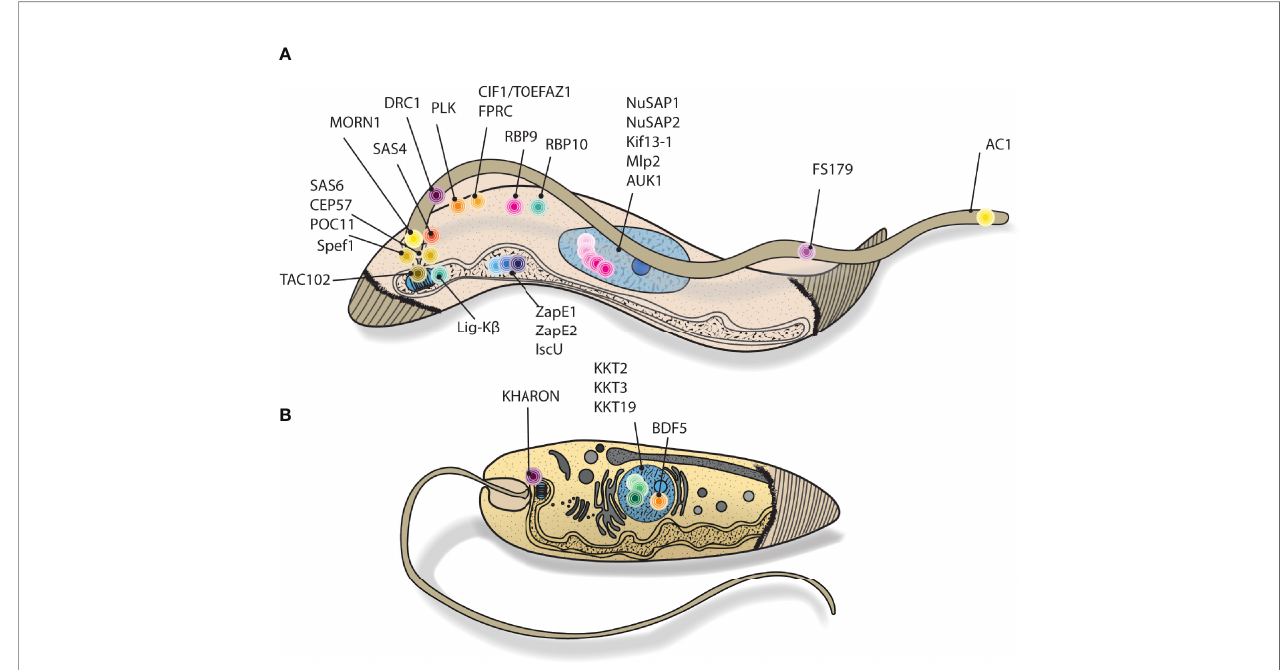
FIGURE 3 | Cartoon depiction of kinetoplastid targets explored using proximity biotinylation. Cutaway style drawing, showing stylised cellular location of (A) T. brucei and (B) Leishmania proximity biotinylation bait proteins. N.B. many of the represented proteins have dynamic localisations throughout the cell